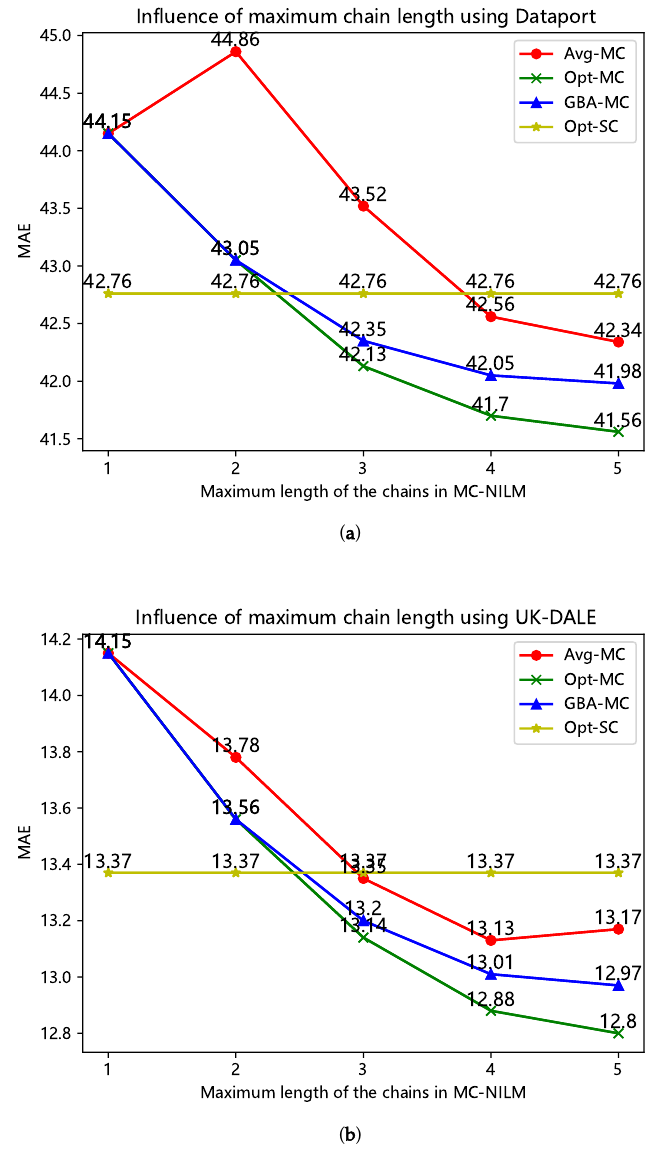
Figure 2. The influence of the maximum chain length on the performance of the MC-NILM. ( a ) Results of experiments using the Dataport; ( b ) Results of experiments using the UK-DALE. Table 2. Numbers of sub-models required for the the Opt-MC and